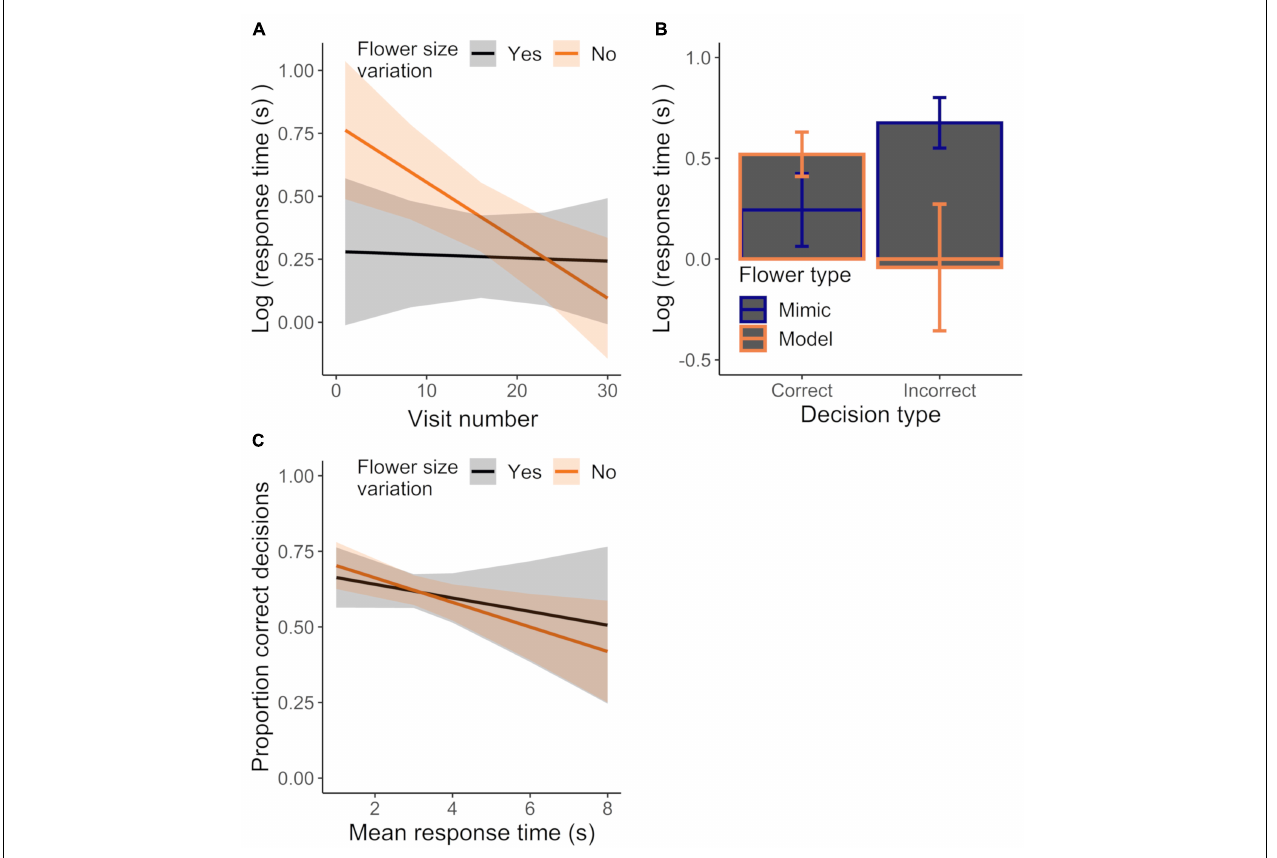
FIGURE 7 | Effect of (A) experience on mean response time for initially-naive bees (same dataset as in Figures 5B–D ) foraging in the control or corolla size variation treatments or (B) sampling behavior (incorrect vs. correct decision) and flower sex on response time, regardless of treatment. Data were analyzed in a single model, but effects of different explanatory variables are shown in separate panels for ease of presentation. (C) Mean response time plotted against the mean proportion of correct decisions for bees foraging in the control or variation treatment. N = 16 and 13 bees in the control and variation treatment, respectively. Plotted lines indicate estimated means and shaded regions indicate 95% confidence